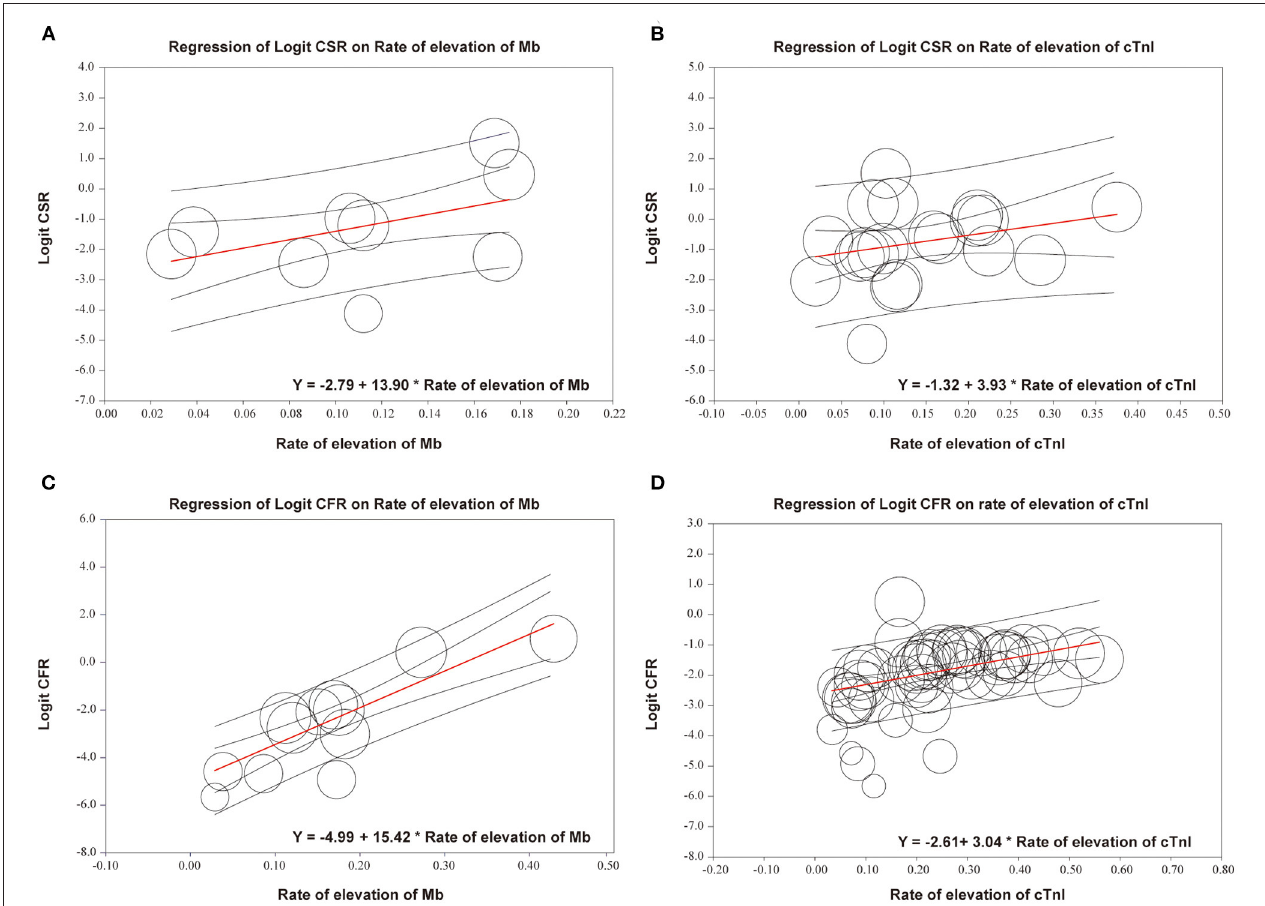
FIGURE 4 | Meta-regression of logit CSR or CFR on the rate of elevation of Mb or cTnI. (A) Regression of logit CSR on rate of elevation of Mb; R = 13.9, 95% CI 3.51–24.29, p < 0.01. (B) Regression of logit CSR on rate of elevation of cTnI; r = 3.93, 95% CI 0–8.52, p < 0.05. (C) Regression of logit CFR on rate of elevation of Mb; r = 15.42, 95% CI 11.2–19.65, p < 0.0001. (D) Regression of logit CFR on rate of elevation of cTnI; r = 3.04, 95% CI 1.84–4.25, p < 0.0001. CSR, case-severity rate; CFR, case-fatality rate; Mb, myoglobin; cTnI, cardiac troponin I. Each circle represents one study; size of the circle is proportional to the population size of each